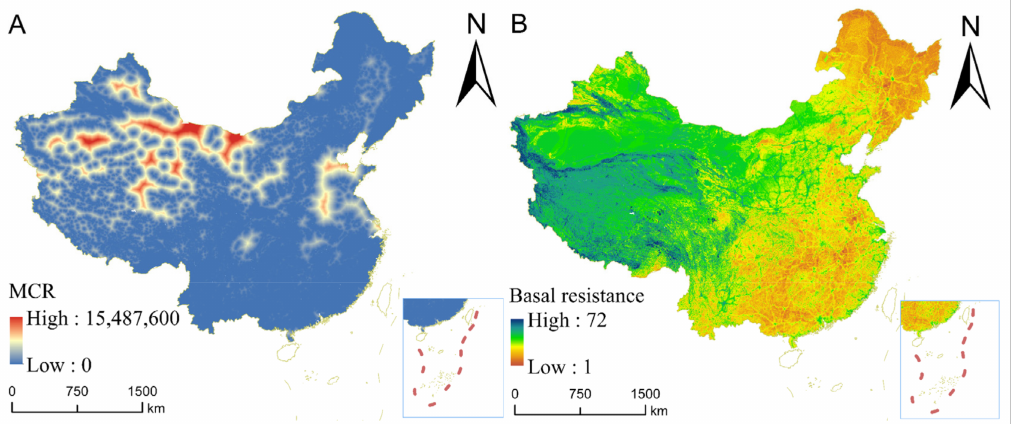
Figure 5. Minimum cumulative resistance surface ( A ), basal resistance ( B ) in the landscape spatial structure in China.